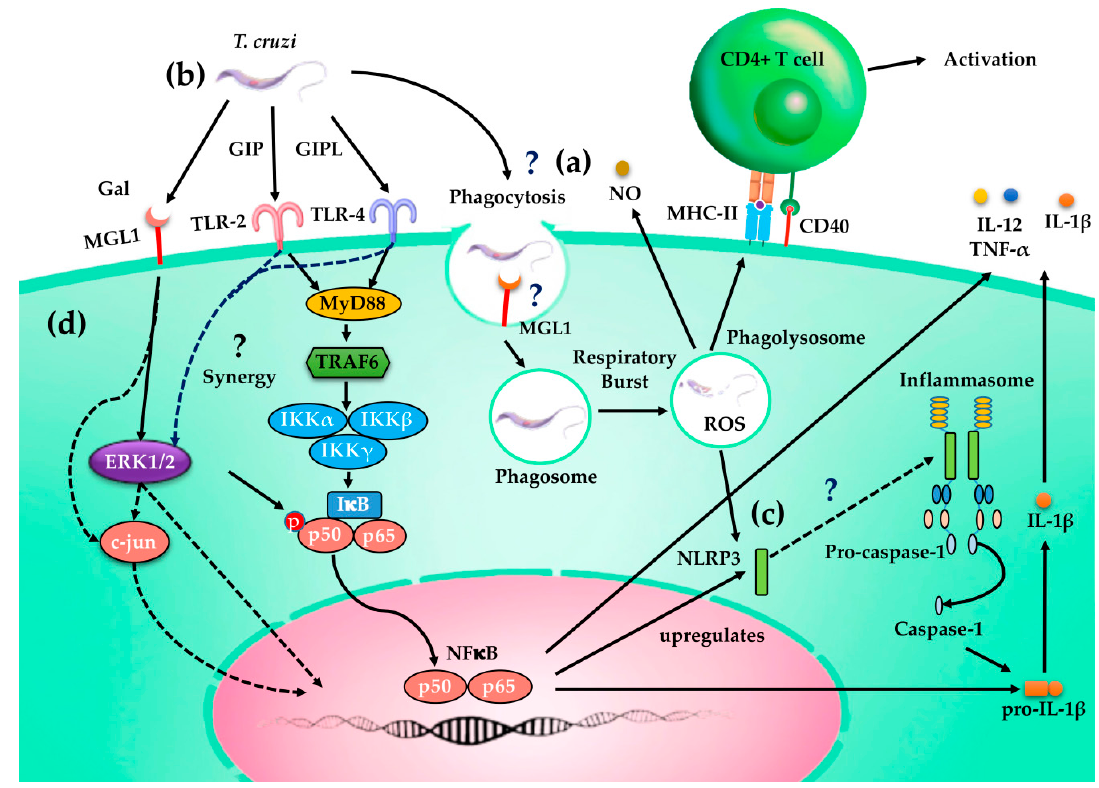
Figure 9. Functions of MGL1 in macrophage response to T. cruzi infection. ( a ) MGL1 recognizes glycosylated molecules and may mediate the uptake of T. cruzi through phagocytosis, inducing antimicrobial e ff ector mechanisms such as respiratory burst and NO production. This leads to the induction of MHC-II and co-stimulatory molecules and increased antigen presentation to CD4 + T cells. ( b ) The recognition of extracellular T. cruzi by MGL1 in M φ induces intracellular signaling through the activation of ERK1 / 2 and NF κ B, as well as the expression of TLR2 and TLR4, that result in the transcription of proinflammatory cytokines, such as TNF- α and IL-12, although anti-inflammatory cytokines such as IL-10 are also produced. ( c ) Moreover, MGL1 appears to favor the active form of the NLPR3 inflammasome; consequently, the assembled of pro-caspase 1, which in turn, by autoproteolysis, generates caspase 1 responsible for the cleavage pro-IL-1 β to its active form of IL-1 β . d) Dashed lines indicate incomplete understood mechanisms.